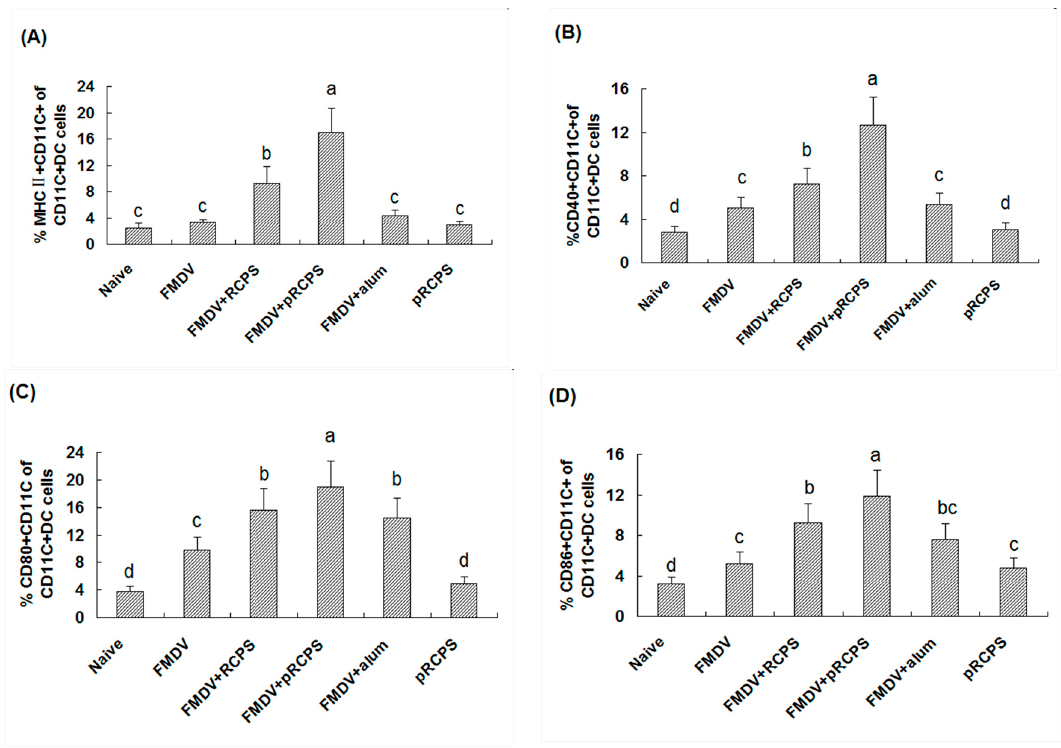
Figure 6. Effect of pRCPS as an adjuvant on the maturation of DCs. The spleens were removed from immunized mice on Day 3 after the first immunization, and the splenocytes suspensions were prepared. The cells were double stained with anti-CD11c-FITC and anti-MHC II-PE, anti-CD11c-FITC and anti-CD80-PE, anti-CD11c-FITC and anti-CD86-PE, or anti-CD11c-FITC and anti-CD40-PE respectively. Then, the expression levels of surface molecular (MHC II, CD40 + , CD80 + , and CD86 + ) were analyzed using FACS. FITC stained positive cells were represent DC cells, The PE stained positive cells are represent the cells which expressed surface molecular. The PE and FITC double positive cells identified as those DCs which expressed surface molecular. The percentage of PE and FITC double positive cells in total cells were selected and recorded in each sample. The percentage of MHC II, CD40 + , CD80 + , and CD86 + in total DCs are shown in ( A – D ). The values are presented as mean ± standard deviation. The different letters on a column differ significantly ( n = 10, p < 0.05).